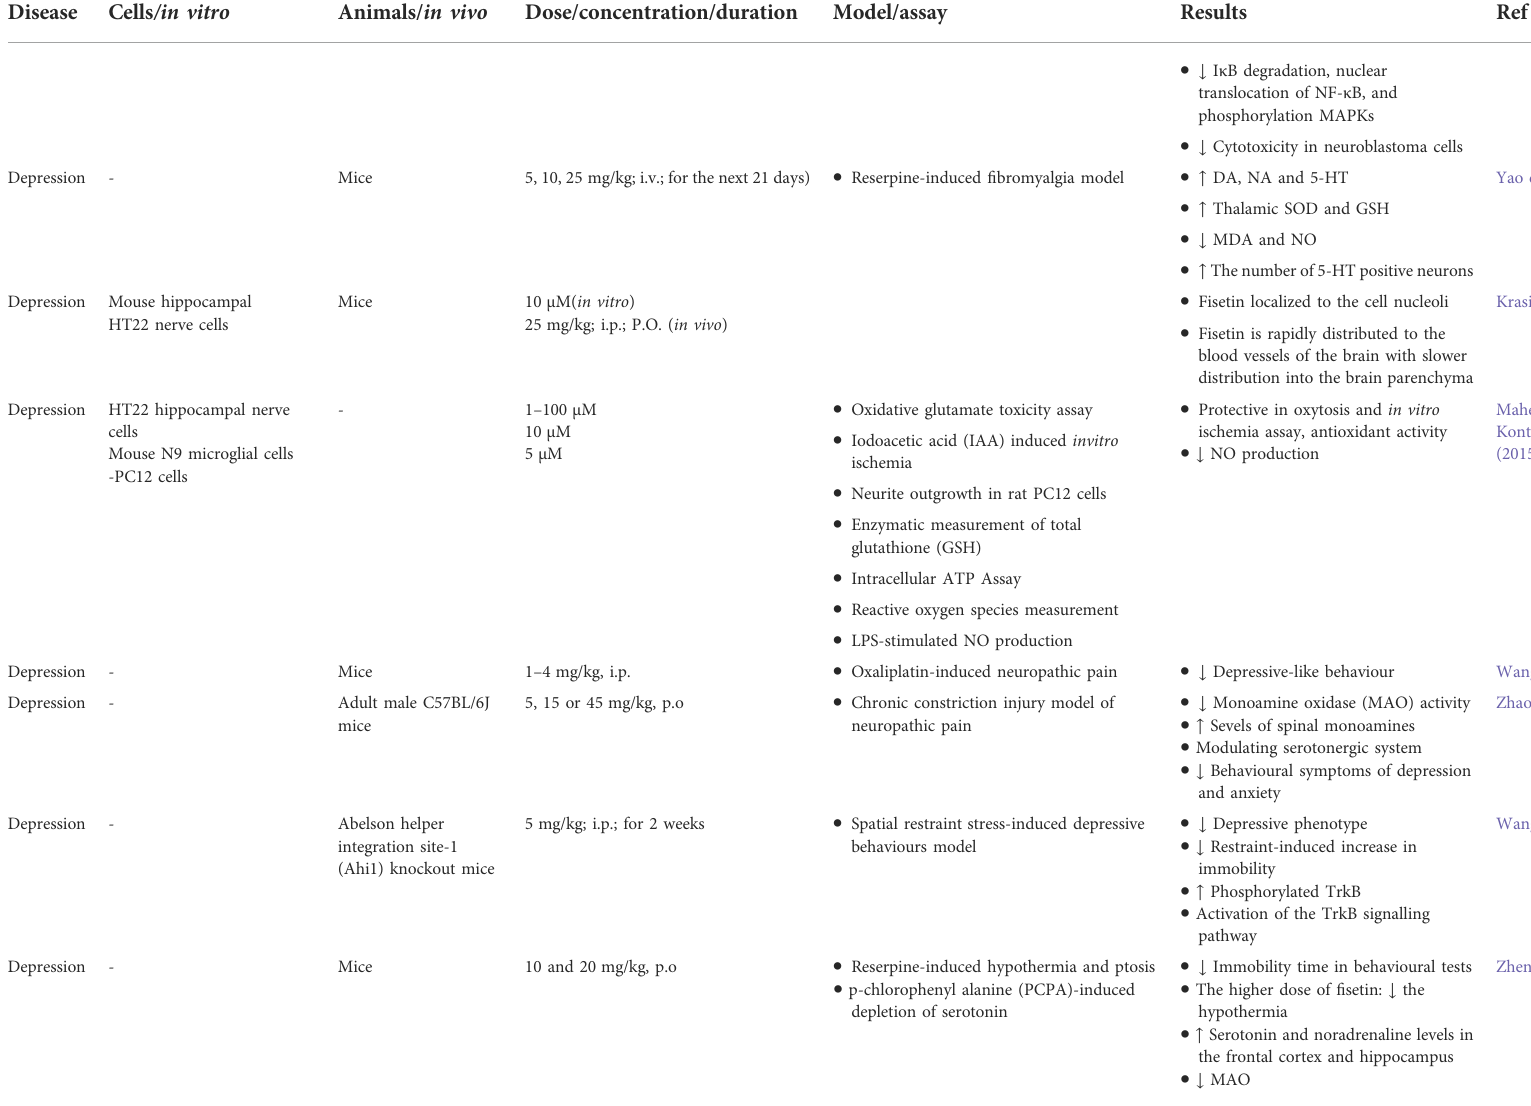
TABLE 1 ( Continued ) Different neurodegenerative disease and the protective role of fi